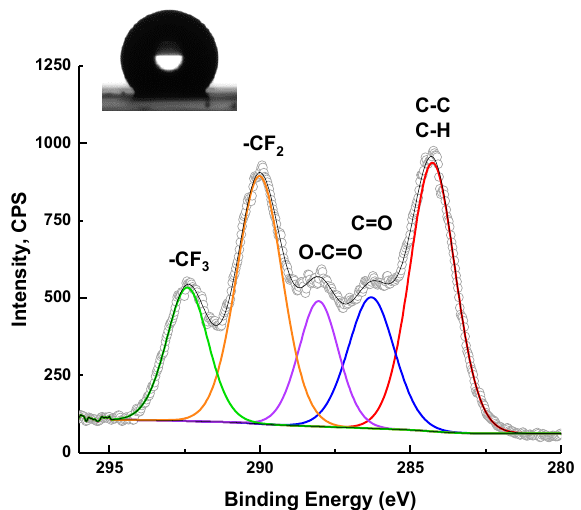
Figure 9. C 1s XPS spectra with static water contact angle (118°) of H8 NP films on modified glass slides.